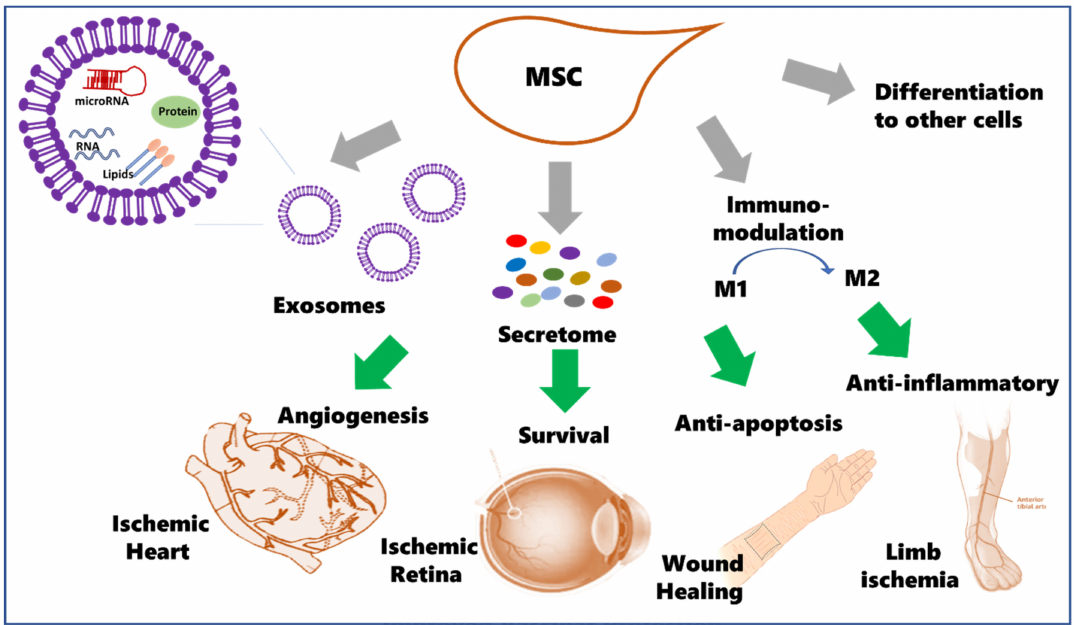
Figure 1. Postulated mechanisms for therapeutic effects of mesenchymal stem cells (MSCs) including differentiation to other cell types, immunomodulation from M1 to M2 as well as the main paracrine effect of MSCs-derived secretome (growth factors, cytokines and exosomes). Exosomes from MSCs contain multiple proteins, lipids, RNAs (mRNA, miRNA, ncRNA). MSCs secretome obtained for therapeutic application can be tailored or modified to the desired cell-specific effects. Therapeutic effects of MSCs-were examined in ischemic heart, retina, wound healing and critical limb ischemia disease